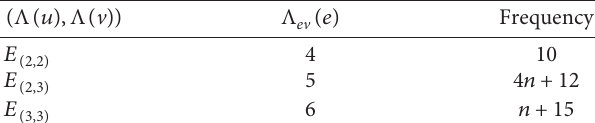
n . Table 4: The edges’ ev-degree of H